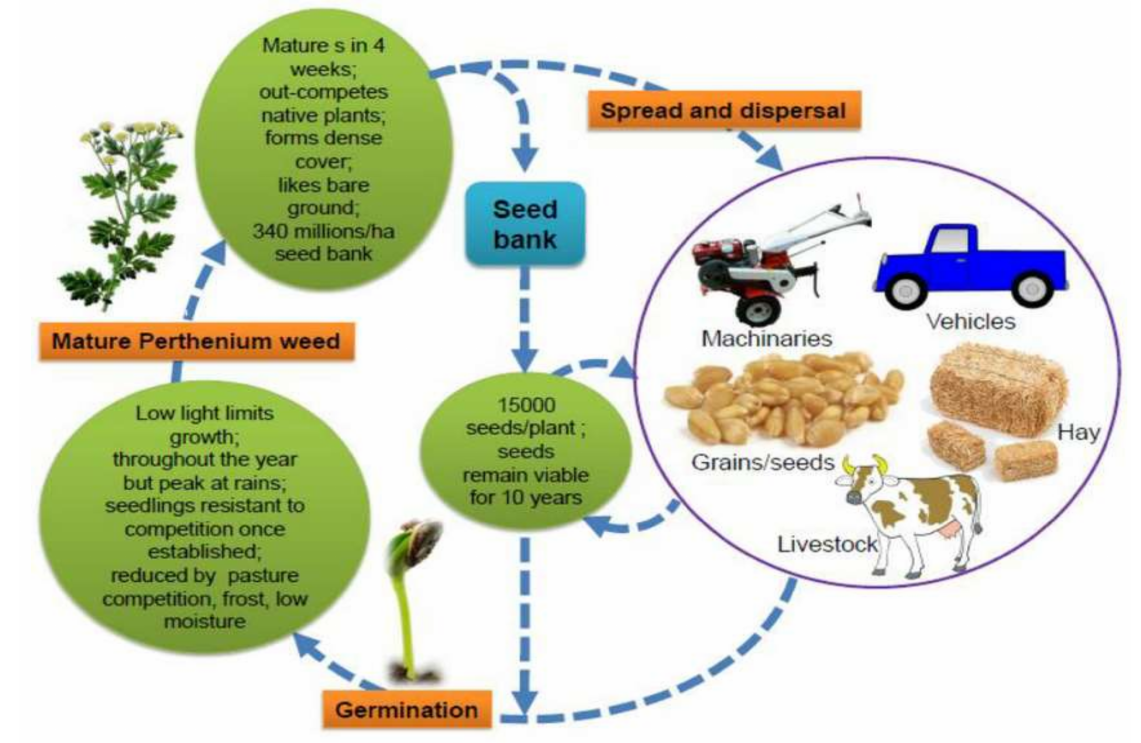
Figure 2. The life cycle of Parthenium weed